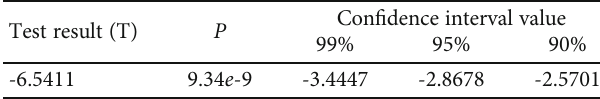
Table 1: Test result of stationarity of load data of hydraulic